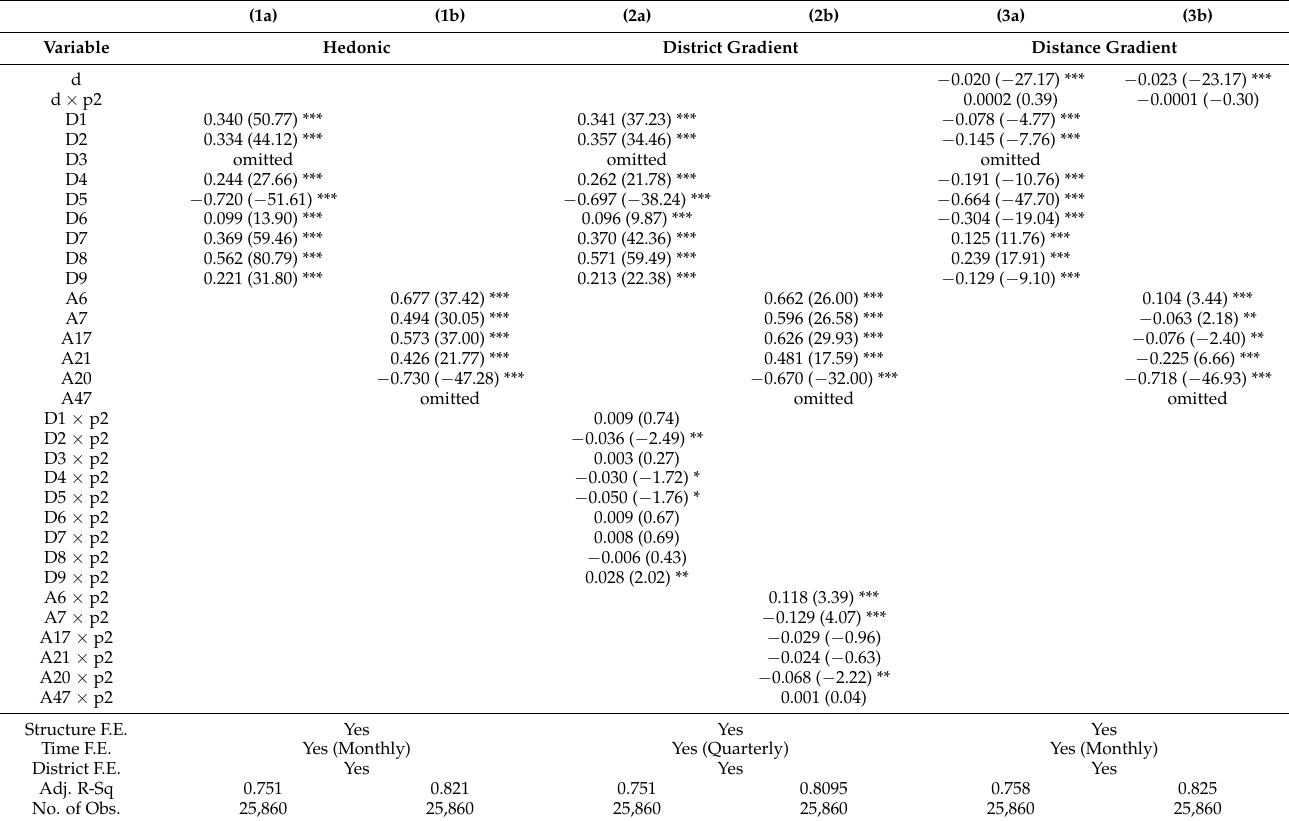
Table 3. Results of the Hedonic and House Price Gradient